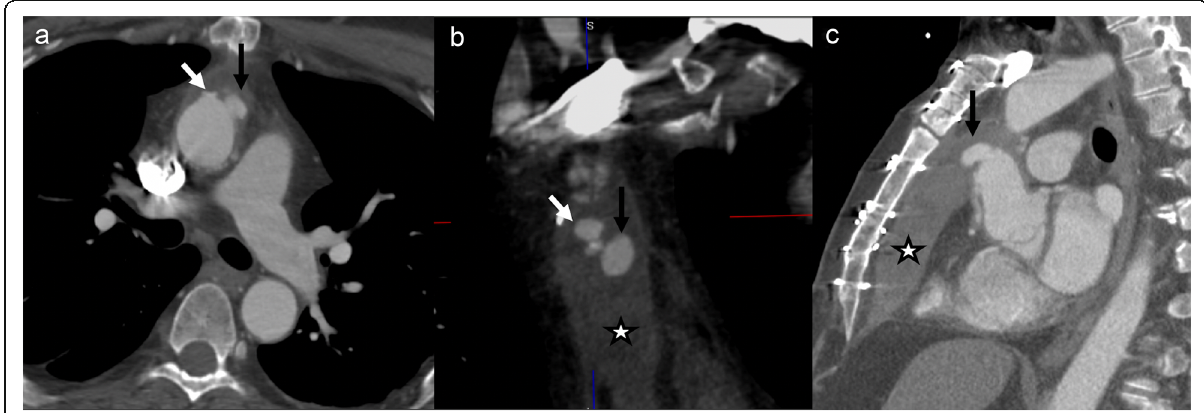
Fig. 18 A 69-year-old male, 6-week status post open ascending aortic aneurysm repair with chest pain, presented with acute chest pain. Axial ( a ), coronal ( b ), and sagittal ( c ) CTA images show a smooth outpouching (black arrow) near graft repair consistent with perfusion catheter stump (expected post-surgical finding). Additionally, there is another irregular outpouching (white arrow), and irregularity and associated anterior pericardial hematoma (star) is concerning for a pseudoaneurysm. The patient had an emergent repeat surgical graft